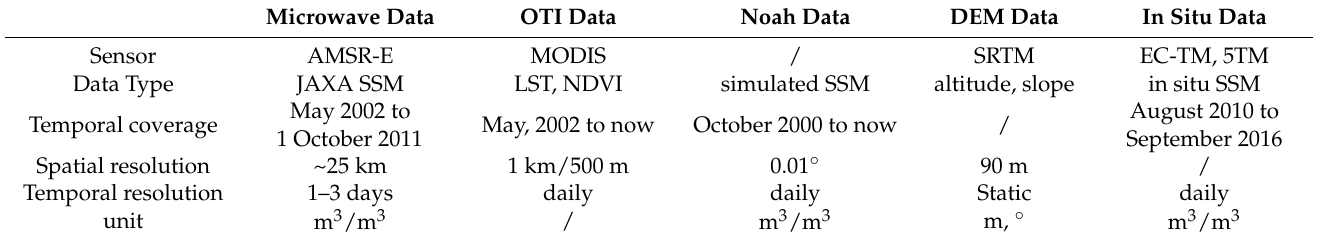
Table 1. A general description of data used in the study. OTI is optical/thermal infrared, DEM is dig- ital elevation model, AMSR-E is the Advanced Microwave Scanning Radiometer—Earth Observing System sensor, MODIS is the Moderate-resolution Imaging Spectro-radiometer, LST and NDVI is the land surface temporal and Normalized Difference Vegetation Index, SSM is the surface soil